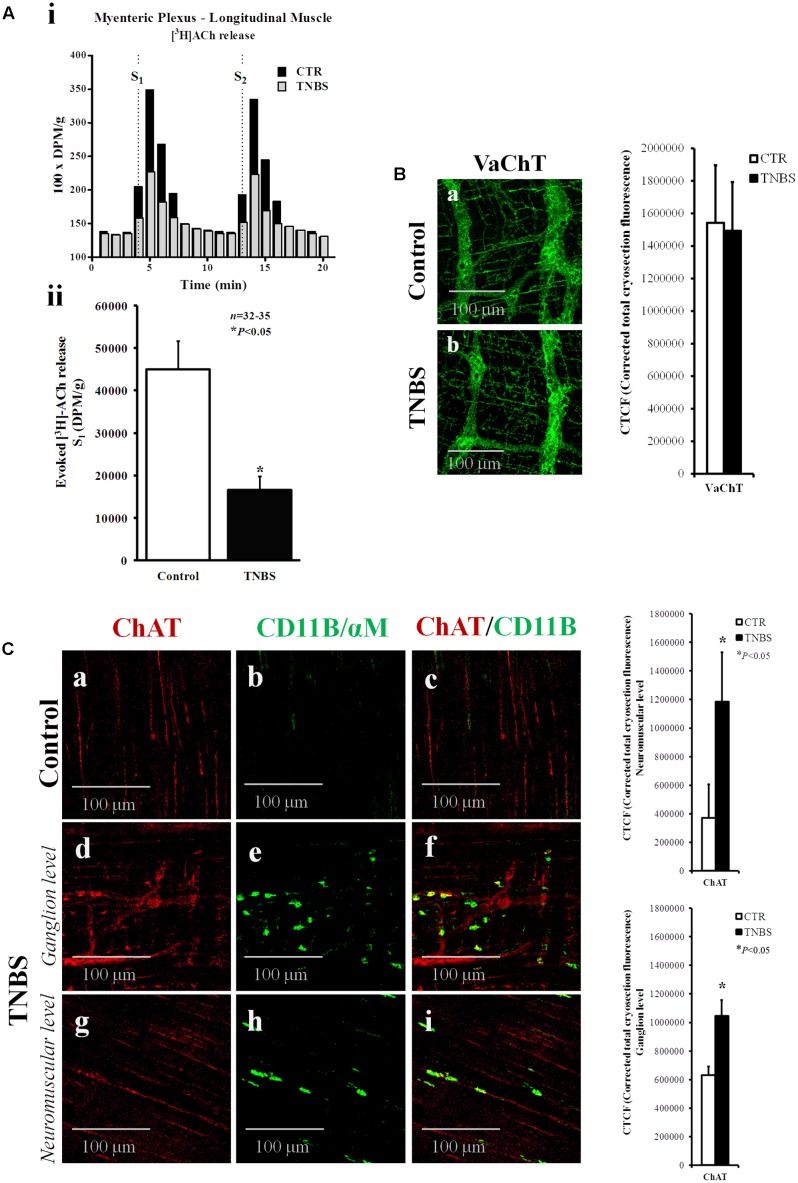
Electrically stimulated myenteric neurons of TNBS-treated rats release smaller amounts of [3H]ACh. (Ai) Ordinates represent tritium outflow from typical experiments using myenteric plexus-longitudinal muscle preparations from the ileum of control (CTR) and TNBS-treated rats expressed in disintegrations per min (DPM)/g of wet tissue. Abscissa indicates the times at which samples were collected. [3H]ACh release was elicited by electrical field stimulation (5 Hz, 1 ms, 200 pulses) twice, starting at 4th (S1) and 13th (S2) minutes after the end of washout (zero time). (Aii) Shown is the amount of [3H]ACh released from electrically stimulated myenteric neurons of the ileum of control and TNBS-treated rats during S1 in DPM/g of wet tissue. ∗P < 0.05 (unpaired Student’s t-test with Welch correction) represents a significant difference from control animals. (B,C) Confocal micrographs of whole-mount preparations of the longitudinal muscle-myenteric plexus of the ileum from control and TNBS-treated rats stained against the vesicular ACh transporter (VAChT) and choline acetyltransferase (ChAT). Please note the presence of ChAT immunoreactivity inside CD11B-positive inflammatory cells surrounding myenteric ganglia and infiltrating the intramuscular layer of TNBS-treated rats. Images are representative of at least five animals per group. Scale bar = 100 μm. Bar charts at right hand-side panels represent mean ± SEM of corrected total cryosection fluorescence (CTCF) staining against VAChT and ChAT, respectively. ∗P < 0.05 (unpaired Student’s t-test with Welch correction) represents a significant difference from control animals.